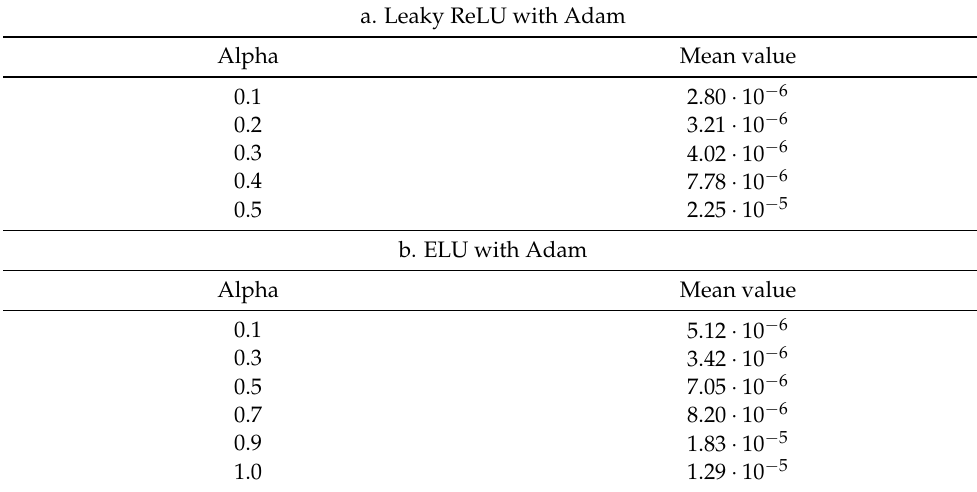
Table 8. Mean value for the error according to Alpha.